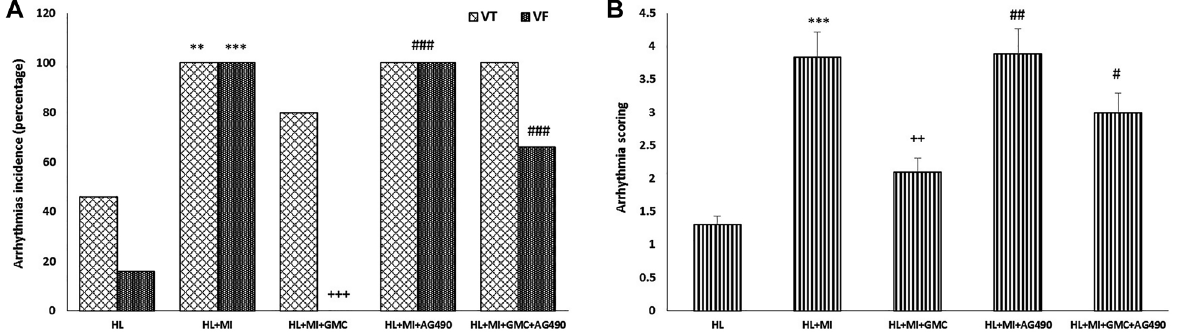
Figure 3: The effects of GMC administration on the incidence of VT and VF (A) and severity (B) of reperfusion-induced myocardial arrhythmias and their reversal by AG490 in hyperlipidemic (HL) rats. Mean ± SD (n=7 in each group). MI, myocardial ischemia reperfusion injury; GMC, Ginsenoside-Mc1; AG490, JAK2 inhibitor; VT, ventricular tachycardia; andVF,ventricular fi brillation. **p<0.01, ***p<0.001 vs.HL group; +++ p<0.001vs.HL + MI group; # p<0.05, ## p<0.01, ### p<0.001vs. HL + MI + GMC